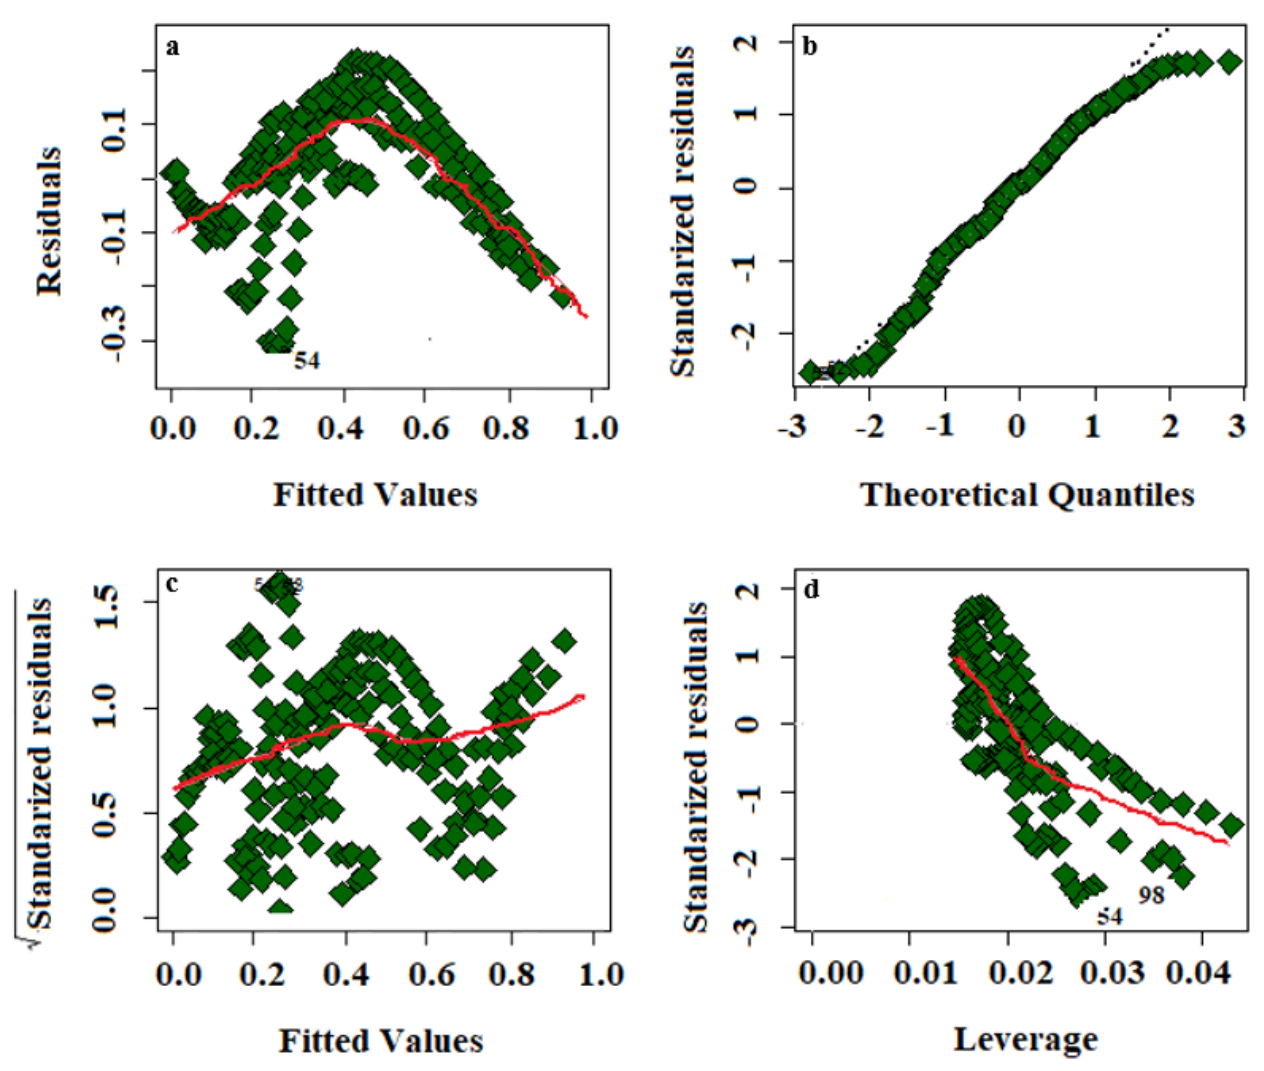
Figure 7. Presentation of the regression diagnostics. Residuals vs. Fitted values ( a ), Normal Q ‐ Q, ( b ), Scale—Location ( c ), and Residuals vs. Leverage ( d ).